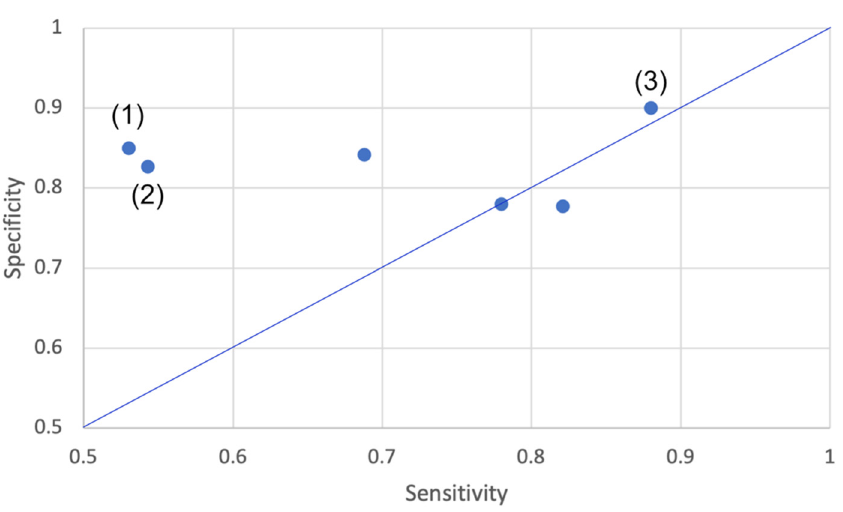
Figure 8. Specificity versus Sensitivity for studies reporting classification performance of sensor derived features. The blue line indicates specificity = sensitivity. (1), (2), and (3) denote values from [46], [44] and [37], respectively.